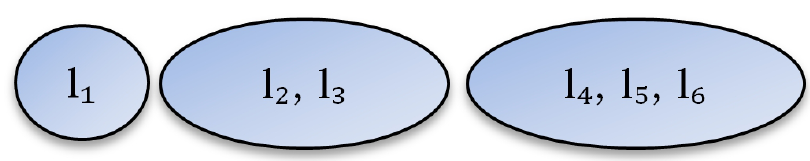
Figure 3. Example of